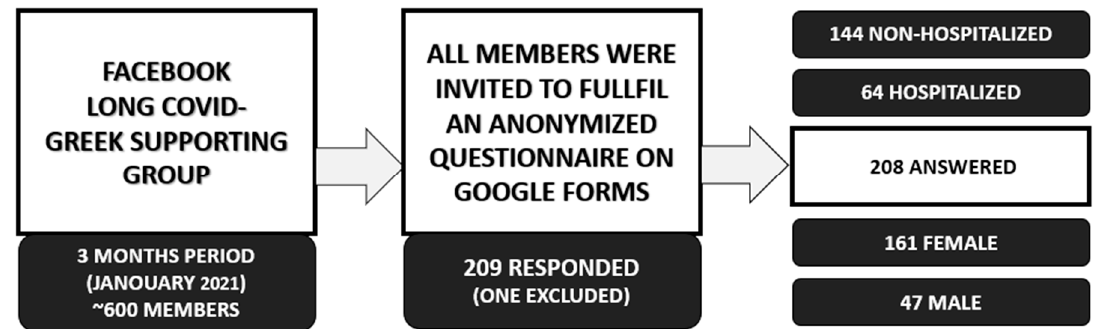
Figure 2. Long COVID Greek Supporting group response to